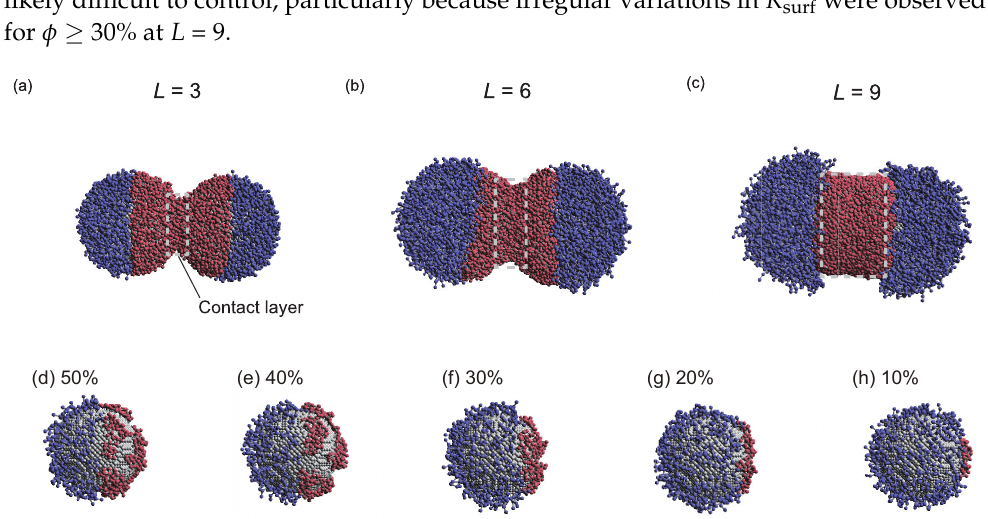
Figure 4. Snapshots of PTNPs at equilibrium acquired at ρ = 6.0 and φ = 50%: ( a ) L = 3, ( b ) L = 6, and ( c ) L = 9. Snapshots of the PTNPs with L = 3 and their left side at equilibrium for φ values of ( d ) 50%, ( e ) 40%, ( f ) 30%, ( g ) 20%, and ( h )